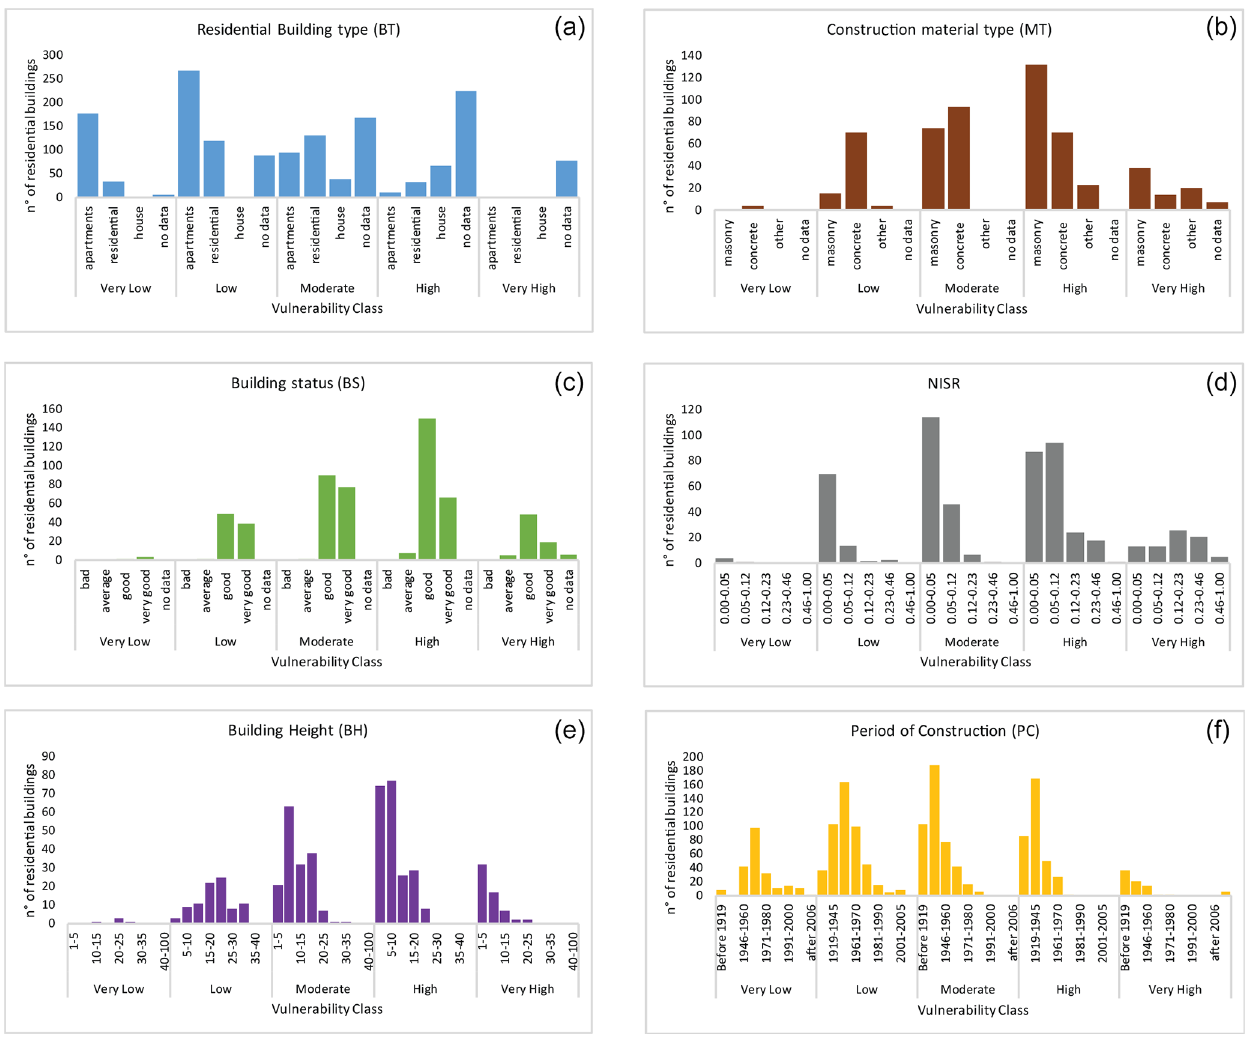
Figure C1. Structural and non-structural building characteristic vulnerability class distribution: residential building type (a) , construction material type (b) , building status (c) , normalized imperviousness surface ratio (d) , building height (e) and period of construction (f) .